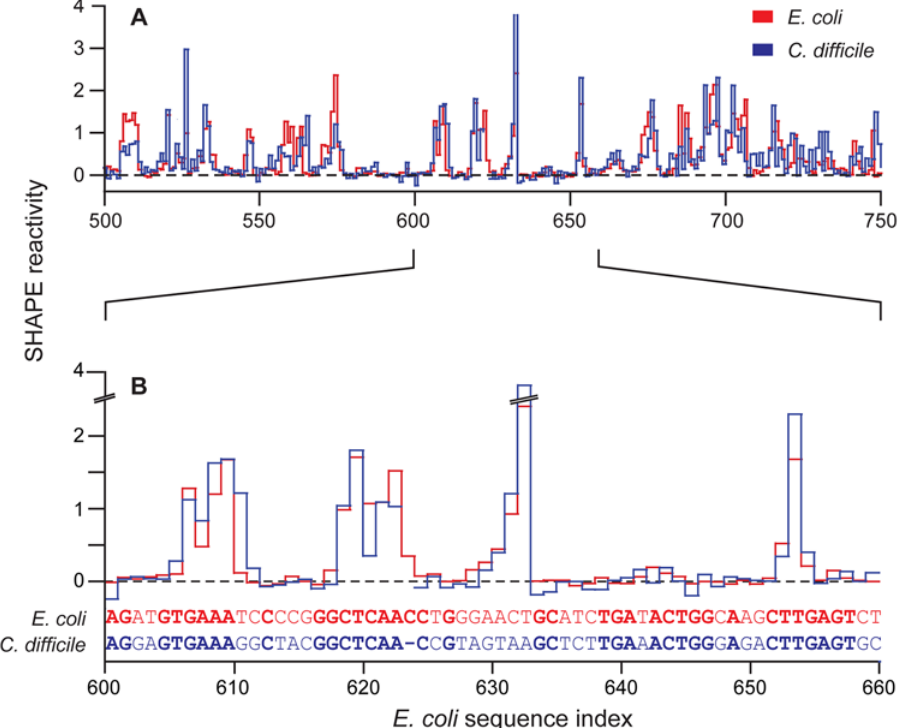
Fig 2. Representative global sequence alignment between E . coli and C . difficile 16S ribosomal RNAs using model-free SHAPE reactivities as the only constraint. Alignment is shown as a function of E . coli sequence numbering. ( A ) Alignment of SHAPE reactivities across a 250-nucleotide window. ( B ) A 60-nucleotide subsection of this alignment, including primary sequences. Areas of sequence identity are emphasized in bold.